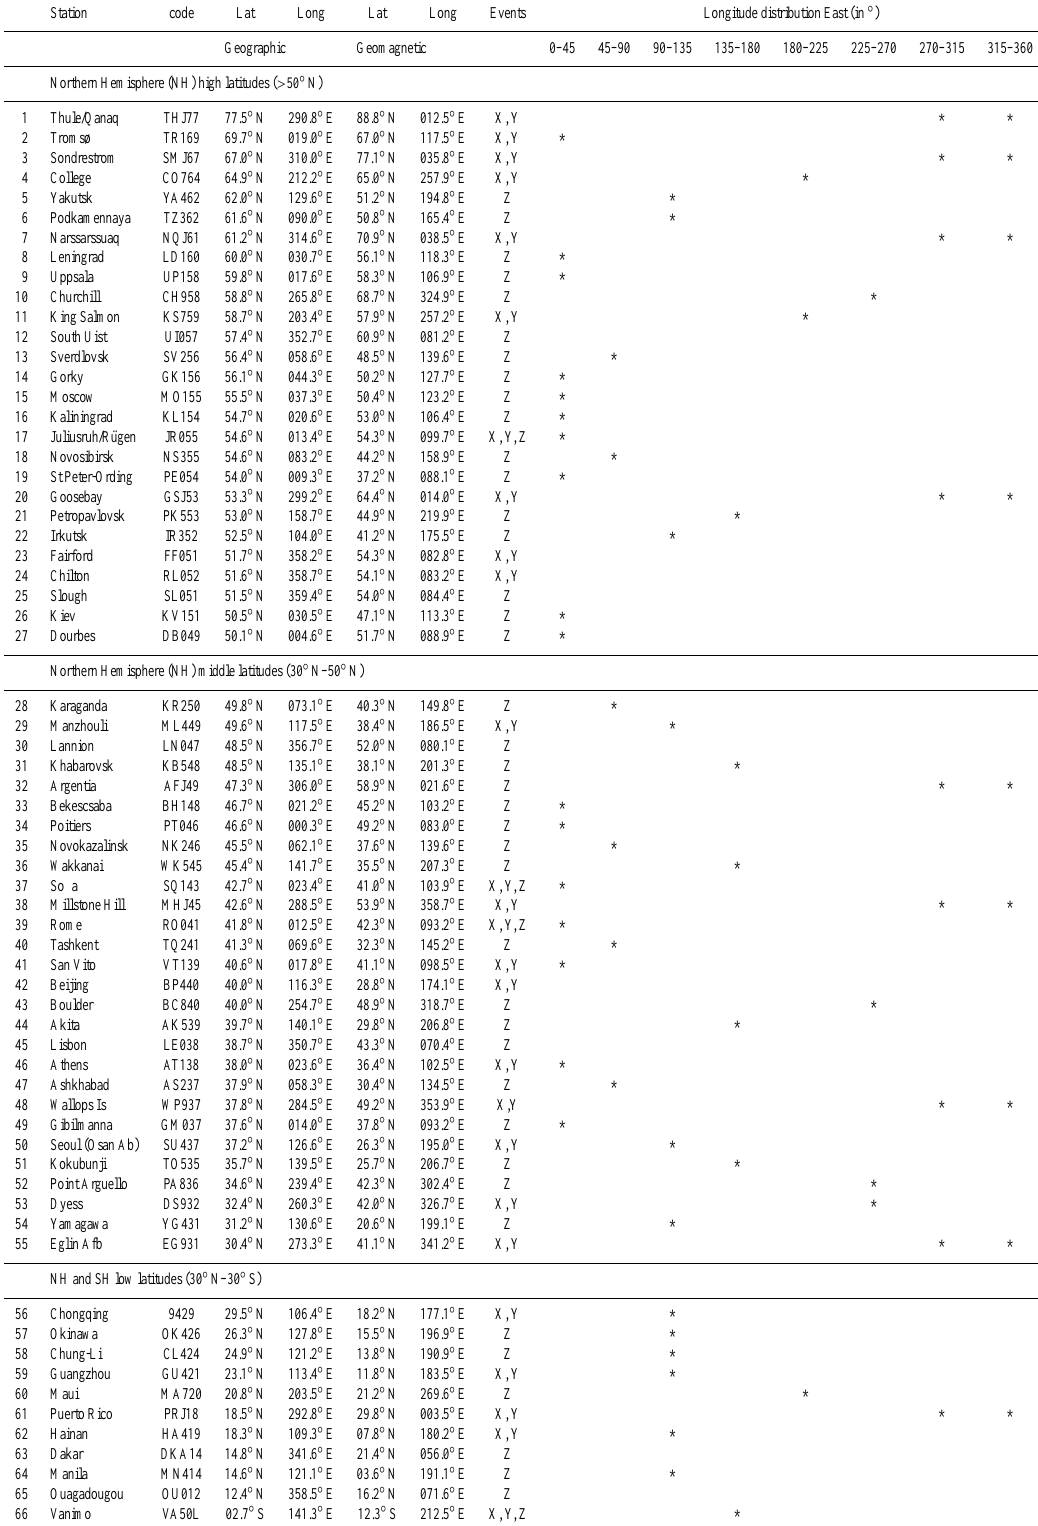
Table 1. Data used for the Halloween events X (29–31 October 2003) and Y (20–21 November 2003) and the giant event Z (13–14 March